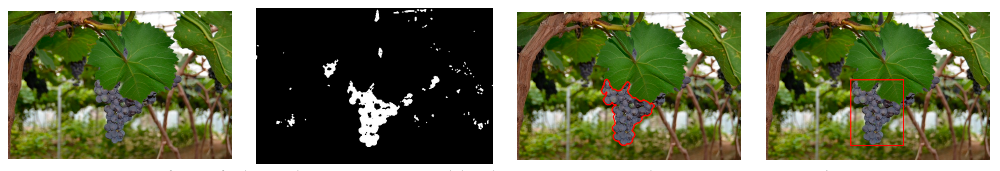
Figure 8. Detection process of the grape clusters under the different occlusion degrees. ( a ) a success detection with partially occlusion (PRA > 75%); and ( b ) a failure detection caused by large region occlusion (PRA < 75%).